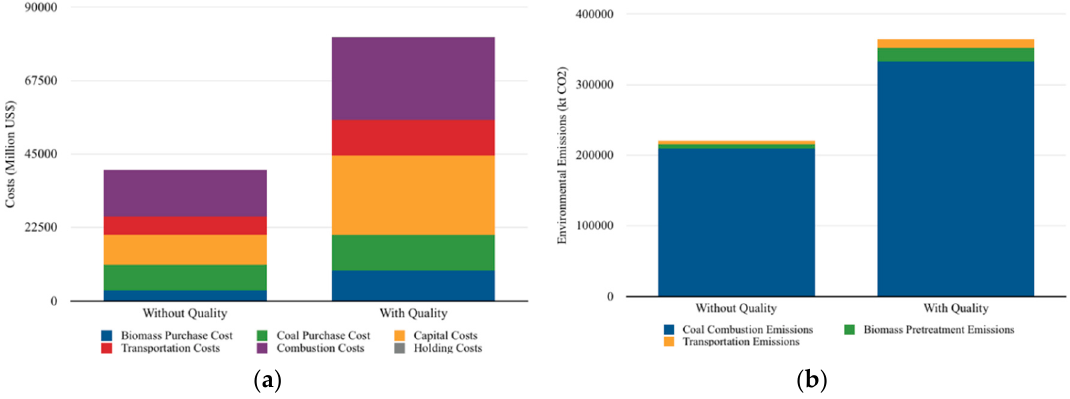
Figure 8. Breakdown of ( a ) costs and ( b ) environmental with and without Quality Considerations.